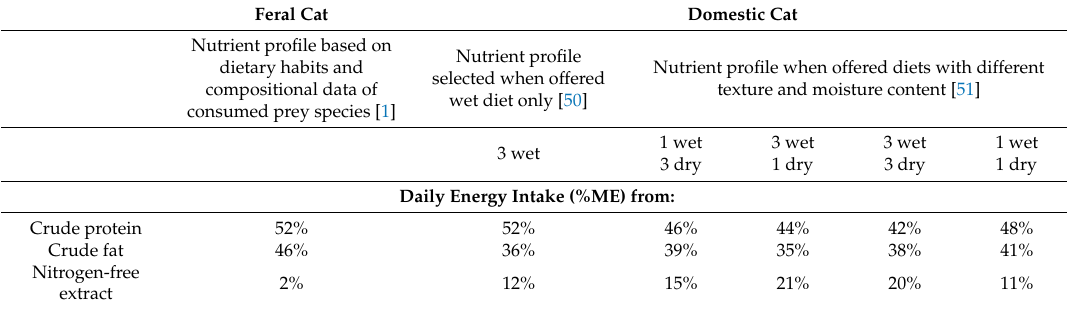
Table 1. Energy distribution of a feral cat diet [1] and the diet selected by the adult domestic cats